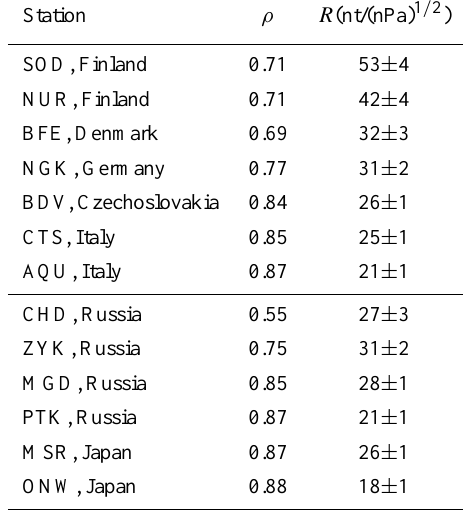
Table 2. The parameters of the linear fit between the H compo- nent at the different stations and the square root of the SW dynamic pressure